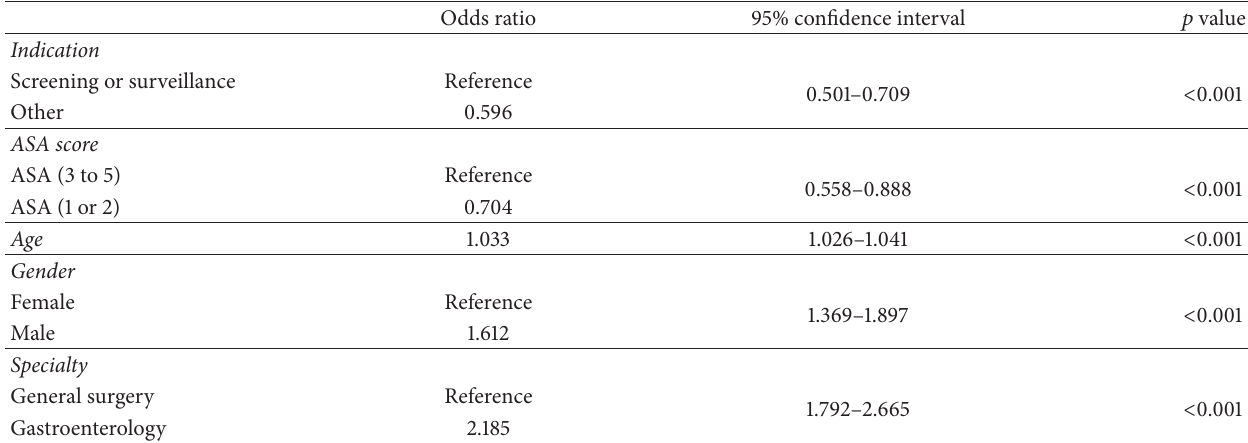
Table 6: Multivariable logistic regression model for polyp